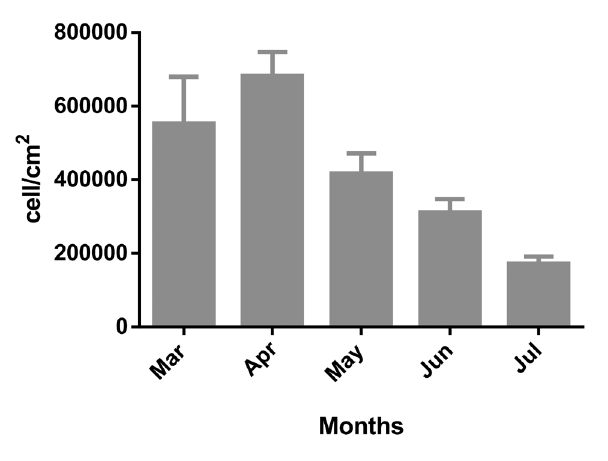
Figure 5 – Diatom densities (cells/cm 2 ) of artificial glass substrate biofilms sampled after a one-month incubation through the sampling period (average ± standard deviations of three replicates) monitored across the dry (March–April) to wet (May–July)